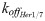
Modelling the effects of stochastic dissociation.2A: Reaction kinetics of Her1/7 proteins binding to the inhibitory sites on her1/7 DNA to switch off expression of her1/7. 2B-F: The oscillating Her1 population levels for five independent cells in the system (blue, red, green, magenta and cyan) and overlaid mean population level of all 100 cells in the system (black) versus time for differing koffHer1/7 values relating to the her1/7 inhibitory reaction described in 2A. The mean population levels of all 100 cells primarily reflect how synchronous the oscillations of neighbouring cells are. Quantification methods for desynchronisation can be found in Methods and S3 Fig. 2B: koffHer1/7=1 min-1. Cell clocks are still in synchrony after 14 oscillations. 2C: koffHer1/7=1/2 min-1. Cell clocks desynchronise in 11–12 oscillations. 2D: koffHer1/7=1/3 min-1. Cell clocks desynchronise in 6–7 oscillations. 2E: koffHer1/7=1/4 min-1. Cell clocks desynchronise in 5–6 oscillations. 2F: koffHer1/7=1/6 min-1. Cell clocks desynchronise in 2–3 oscillations. 2G: Mean population levels of 100 cells for seven different simulations, for koffHer1/7=1/3 min-1. There is variability in the embryos and cell clocks desynchronise in 6–8 oscillations. The figure demonstrates that noisy gene regulation can drive desynchronisation in Notch mutants.